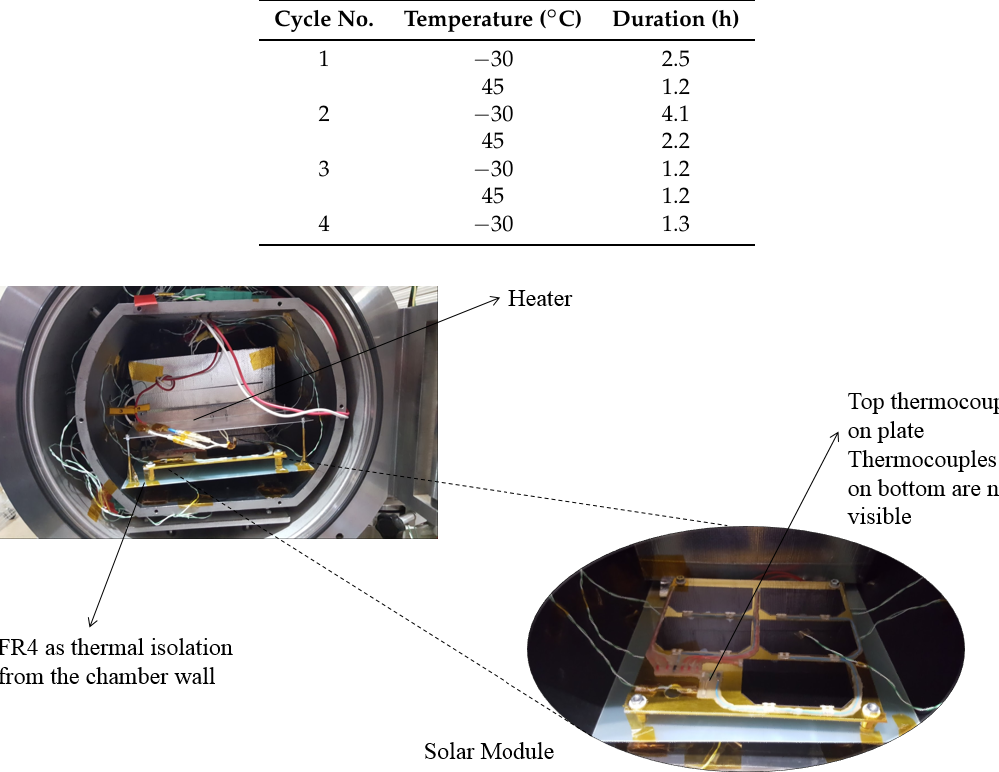
Figure 9. Temperature and pressure during TVAC qualification of solar